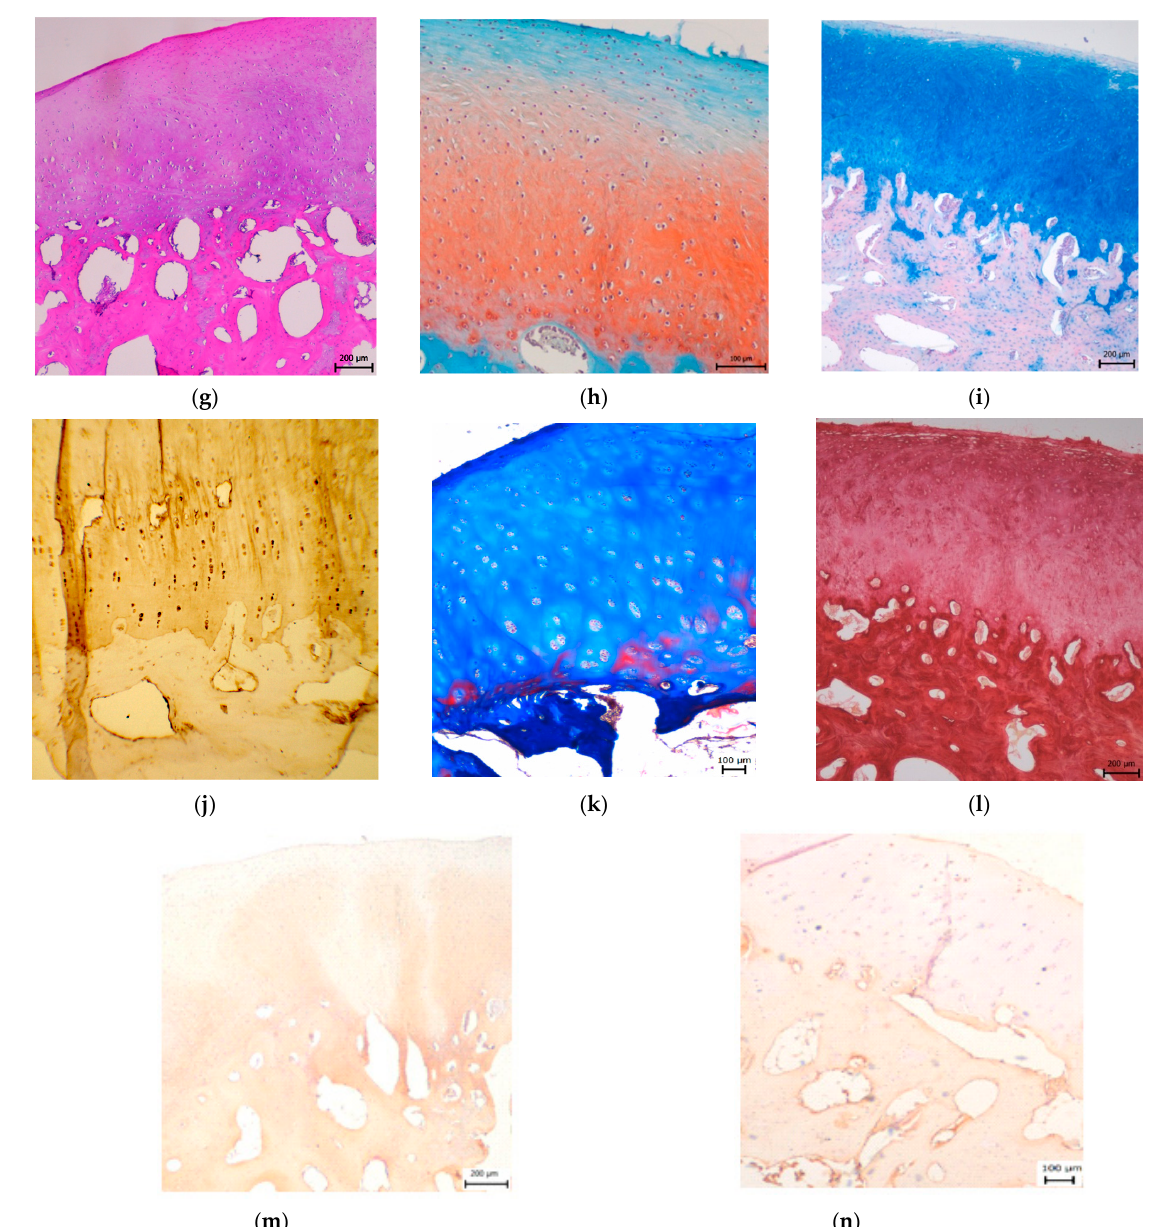
Figure 4. Histological evaluation of the articular cartilage regeneration in the treated group at 6 months post ‐ operation. ( a – f ) The treatment with CAL biocement. ( a ) The formation of hyaline cartilage ‐ like tissue, cartilage layers, and smooth surface as the native cartilage could be seen with Haematoxylin ‐ eosin staining (scale bar 200 μ m). ( b ) Safranin O staining and ( c ) Alcian blue staining showed similar stain intensity and morphological similarity to normal hyaline cartilage indi ‐ cating a considerable amount of proteoglycans (scale bar 200 μ m). ( d ) Immunohistochemical detection of type II collagen (scale bar 100 μ m). Homogeneous distribution of collagen was detected by ( e ) Masson´s trichrome (scale bar 50 μ m), and ( f ) Picrosirius red (scale bar 200 μ m). ( g – l ). The treatment of C biocement. ( g ) Haematoxylin ‐ eosin staining (scale bar 200 μ m), ( h ) Safranin O staining (scale bar 100 μ m), ( i ) Alcian blue staining (scale bar 200 μ m), ( j ) immunohistochemical evidence of collagen II (100 μ m), ( k ) Masson´s trichrome staining (scale bar 100 μ m), ( l ) Picrosirius red staining (scale bar 200 μ m). ( m , n ) immunohistochemical detection of collagen I, CAL treated defects, ( m ) scale bar 200 μ m, ( n ) scale bar 100 μ m.